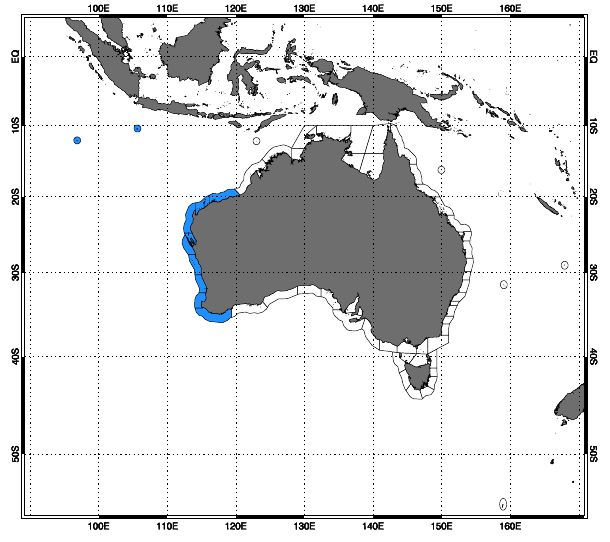
Fig. 4. Desired warning scheme for the Sumatra 2004 event. Coastal zones assigned a marine threat are shaded in